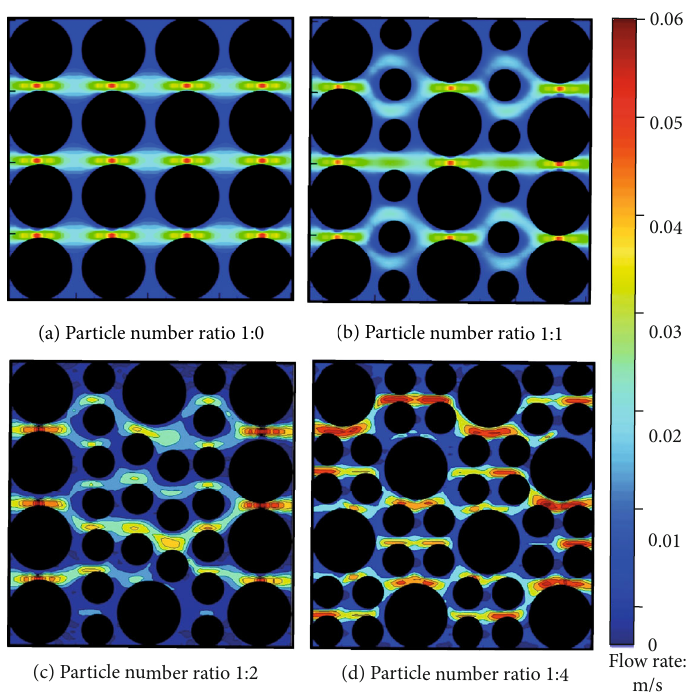
Figure 12: Flow contours for circular particles in a quadrate